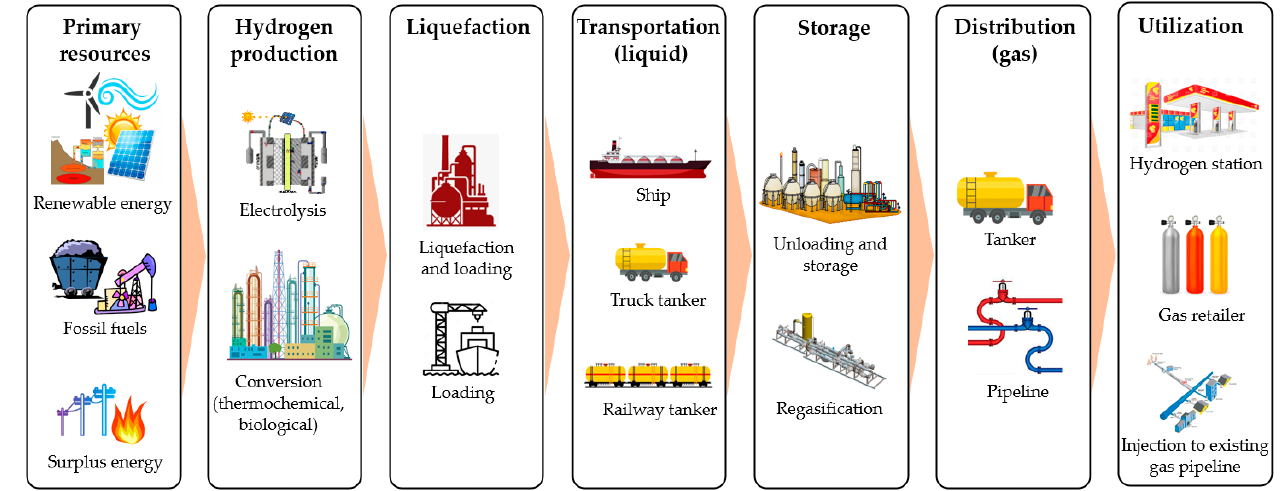
Figure 1. Basic liquid hydrogen supply chain, covering hydrogen production, liquefaction, transportation, storage, trans- portation, and utilization.